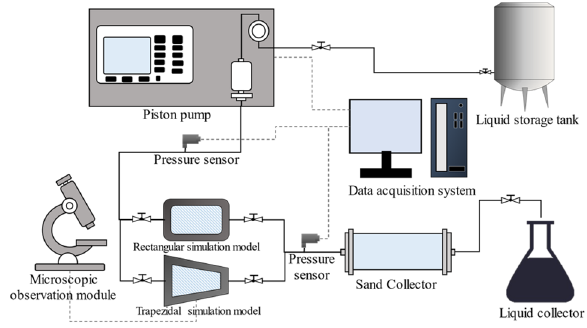
Fig. 2 Schematic of the visualization system for the microscopic